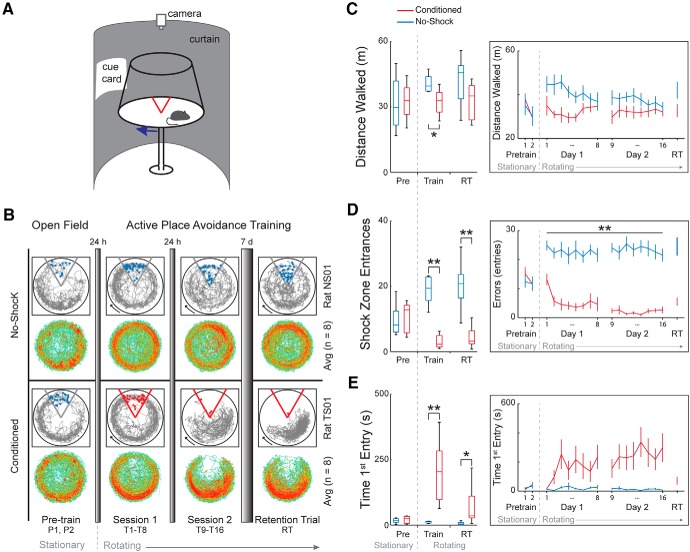
Memory-related behavior is different between conditioned and no-shock rats. A, Rats were placed on a rotating arena and conditioned to avoid a mild foot shock within a 60° sector that was stationary within the room. The no-shock group was exposed to the same conditions, but without foot shock. B, The rats were given two pretraining trials on a stationary arena without shock. The next day the rats started 2 d of conditioning (sessions 1 and 2). Each day a conditioning session consisted of eight training trials. One week after the end of conditioning, the rats were given a retention trial to test memory. For the conditioned group, the retention trial was conducted with the shock on. All trials were 10 min with at least 10 min intertrial intervals. Example paths (in gray) of one no-shock rat and one conditioned rat are shown over the course of training. The red dots represent where the animal received shocks and blue dots indicate where the animal would have received shock if the shock had been present. The heat maps show average time spent for all rats in each 0.3 × 0.3-cm region for each group. Red represents an average dwell of >0.017 s. By the end of the training period, the conditioned rats avoid the 60° sector (bottom) while the no-shock rats do not exhibit a place bias. C–E, Box plots of behavioral measures for the pre-training session, the training sessions (trials 1–16), and the retention trial show there are differences between no-shock and conditioned rats. Asterisks in the box plots (C–E, left) indicate a main effect of group, while asterisks in the line graph (C–E, right) indicate group differences. no-shock, n = 8; conditioned, n = 8. Plots to the right of the boxplots represent mean ± SEM on a trial-by-trial basis; *p < 0.05, **p < 0.01.